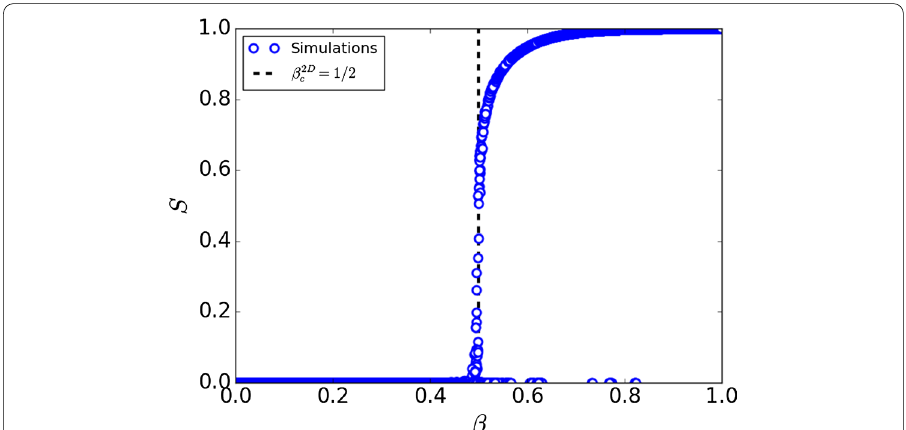
Fig. 8 Epidemic spread in 2D square lattice. The simulations were performed for N = L × L with L = 1000 . The epidemic threshold is β 2 D c = 1 /